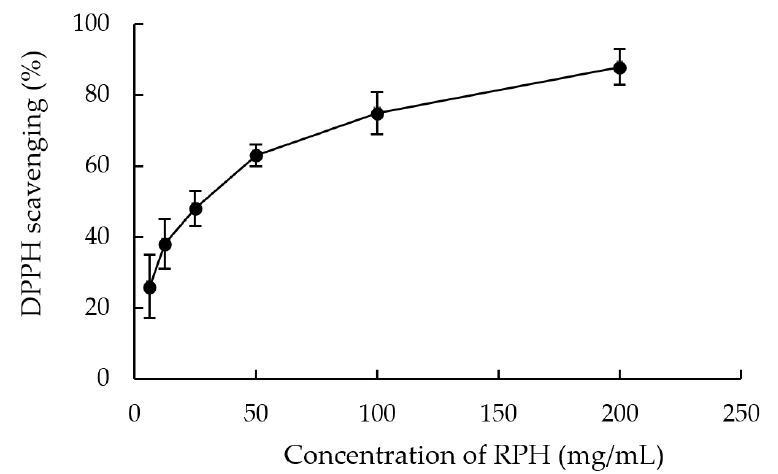
Figure 2. Influence of RPH concentration on the scavenging activity of 1,1-diphenyl-2- picrylhydrazyl (DPPH).